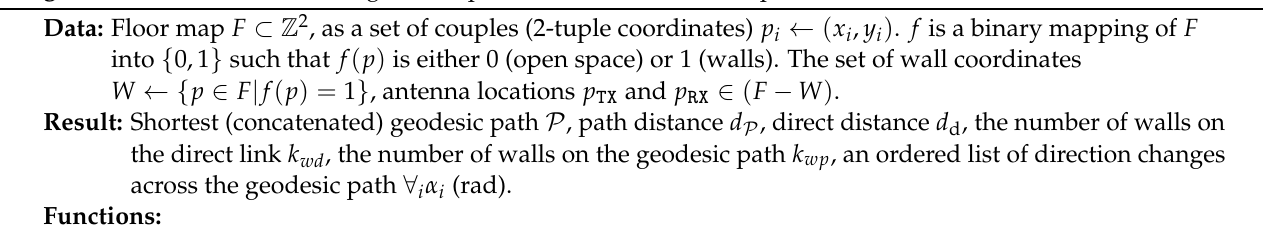
Algorithm 1: Tool to determine geodesic paths and other PL model parameters Z 2 , as a set of couples (2-tuple coordinates) p Data: Floor map F ⊂